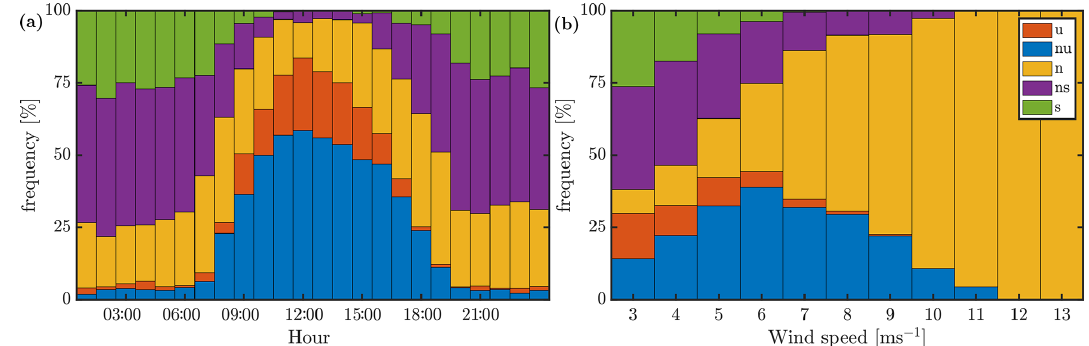
Figure 7. Frequency of z/L at 10ma . g . l . divided in stability classes per hour (a) and per wind speed (b) from measurements at M7. The stability classes are found in Table 2. The time is in UTC.